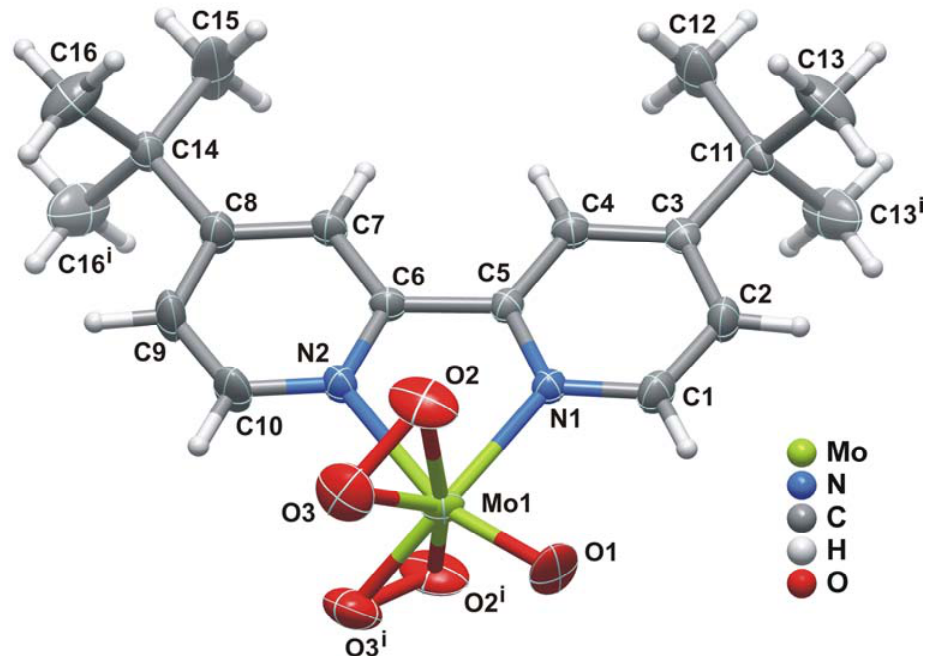
) (tbbpy) molecular unit present Figure 1. Schematic representation of the neutral MoO(O 2 2 in the crystal structure of 1 , showing the labelling scheme for all non-hydrogen atoms. Thermal ellipsoids are drawn at the 50% probability level and hydrogen atoms are represented as small spheres with arbitrary radii. The disorder associated with the coordinated peroxo (O2'-O3') and oxo (= O1') groups [21.9(7)% occupancy] has been omitted for clarity. Table 1 collects selected bond lengths and angles for the distorted O } coordination environment. Symmetry transformation used to bipyramidal {MoN 2 5 generate equivalent atoms: (i) x , 1.5-y , z